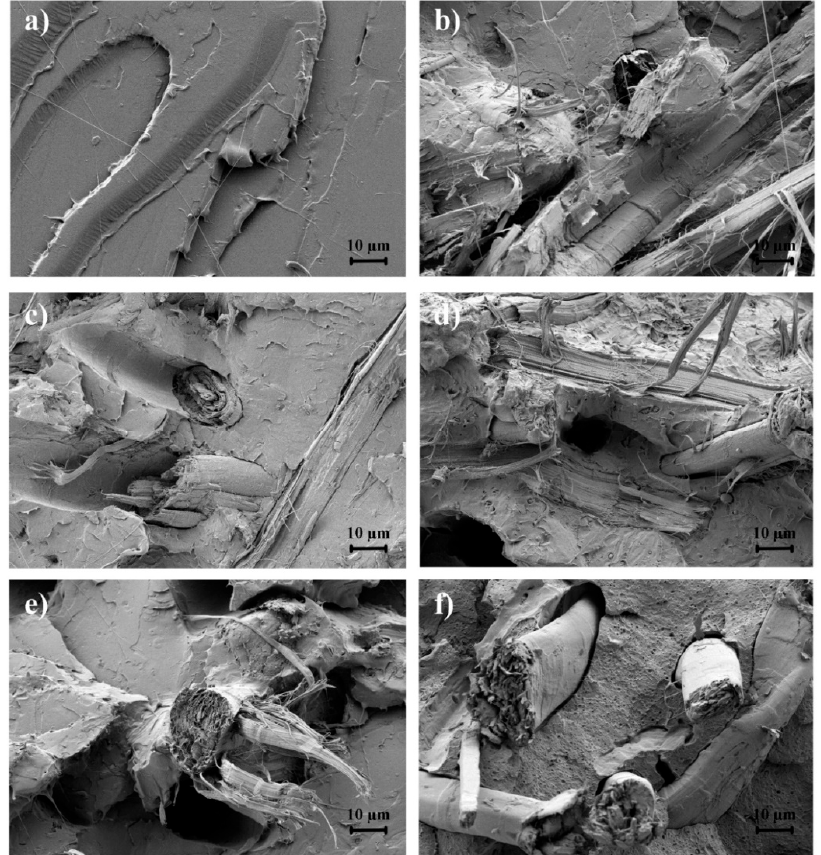
Figure 4. Field emission scanning electron microscopy (FESEM) images of the fracture surfaces of the polylactide (PLA) / flaxseed fiber (FF) pieces of: ( a ) PLA; ( b ) PLA / FF; ( c ) PLA / FF + (3-glycidyloxypropyl) trimethoxysilane (GPTMS); ( d ) PLA / FF + epoxy-based styrene-acrylic oligomer (ESAO); ( e ) PLA / FF + poly(styrene- co -glycidyl methacrylate) (PS- co -GMA); ( f ) PLA / FF + maleinized linseed oil (MLO). Images were taken at 1000 × with scale makers of 10 µm.